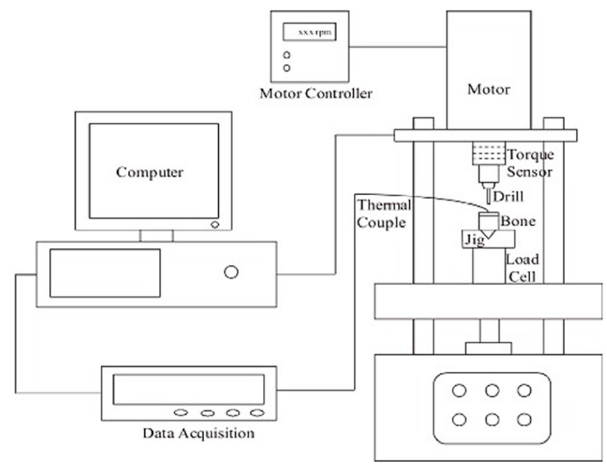
Figure 5. Schematic diagram of the bone drilling process [37]. Nowadays, bone drilling is an increasingly common surgical operation. As a result of the ageing population, the prevalence of bone diseases is expected to rise dramatically. Due to human ageing and associated disorders, it is vital to develop proper bone drilling methods to fully understand the impacts of drilling mechanics